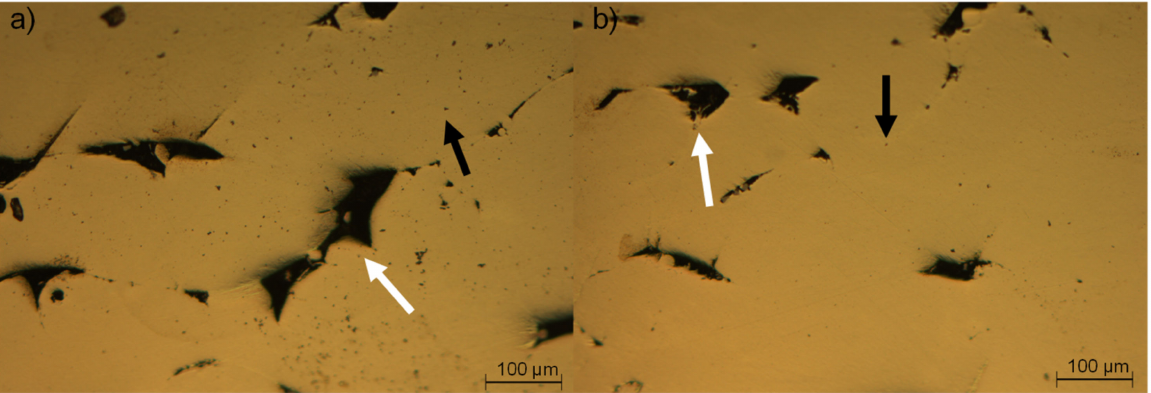
Figure 5. Porosity (arrowed in black) and lack of fusion (arrowed in white) defects on the manufac- tured samples: SEM micrograph of ( a ) Ti-50 × 1 and ( b ) Ti-50 × 2